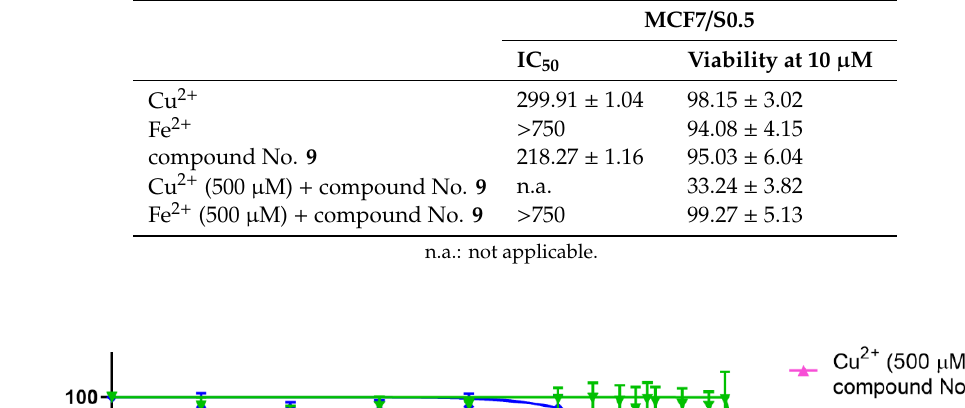
Table 1. Cytotoxicity of Cu 2 + , Fe 2 + and 4 (cid:48) -trifluoromethylphenyl derivate ( 9 ) alone and in combination.